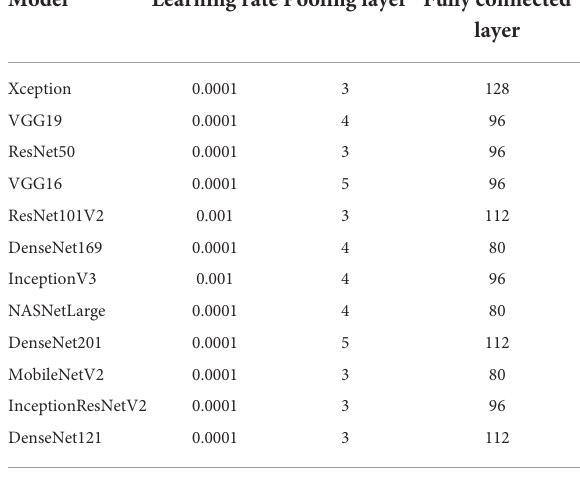
TABLE 3 Training parameters for the models without data augmentation.